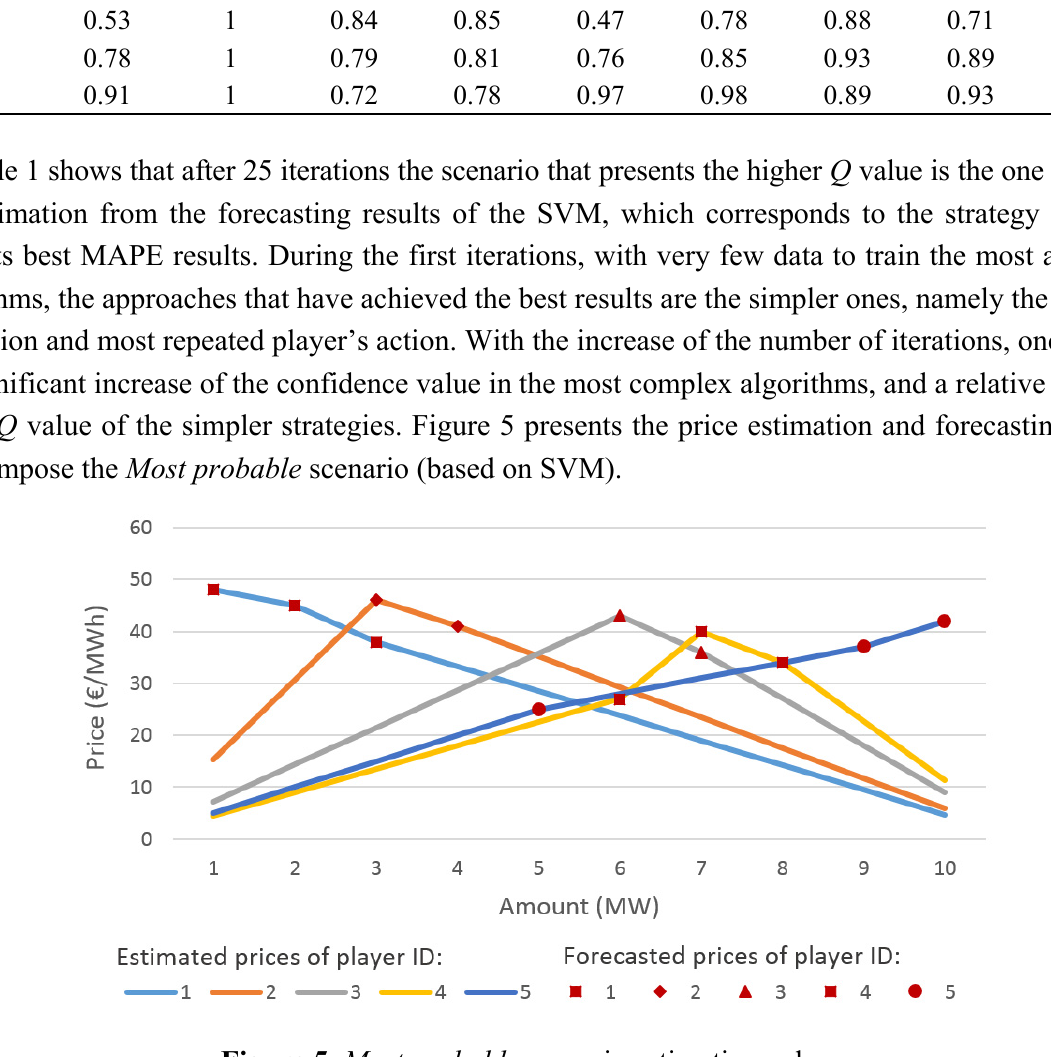
Figure 5. Most probable scenario estimation